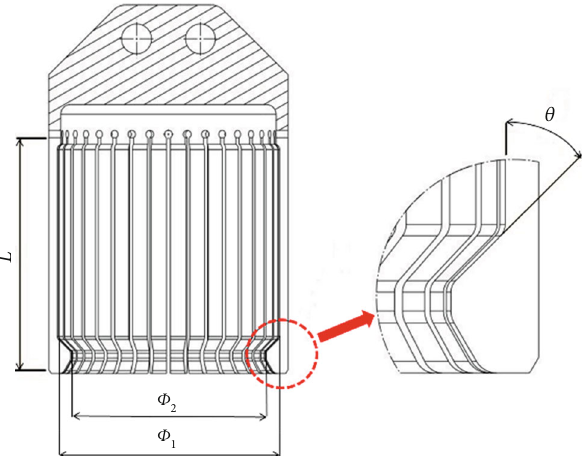
Figure 3: Main parameters of the fi nger